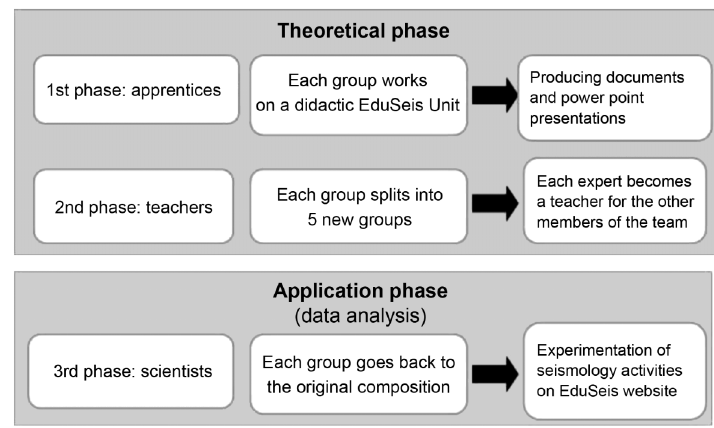
Fig. 2. A scheme of the e-learning experiment at the ITIS «Majorana» technical school, Naples.